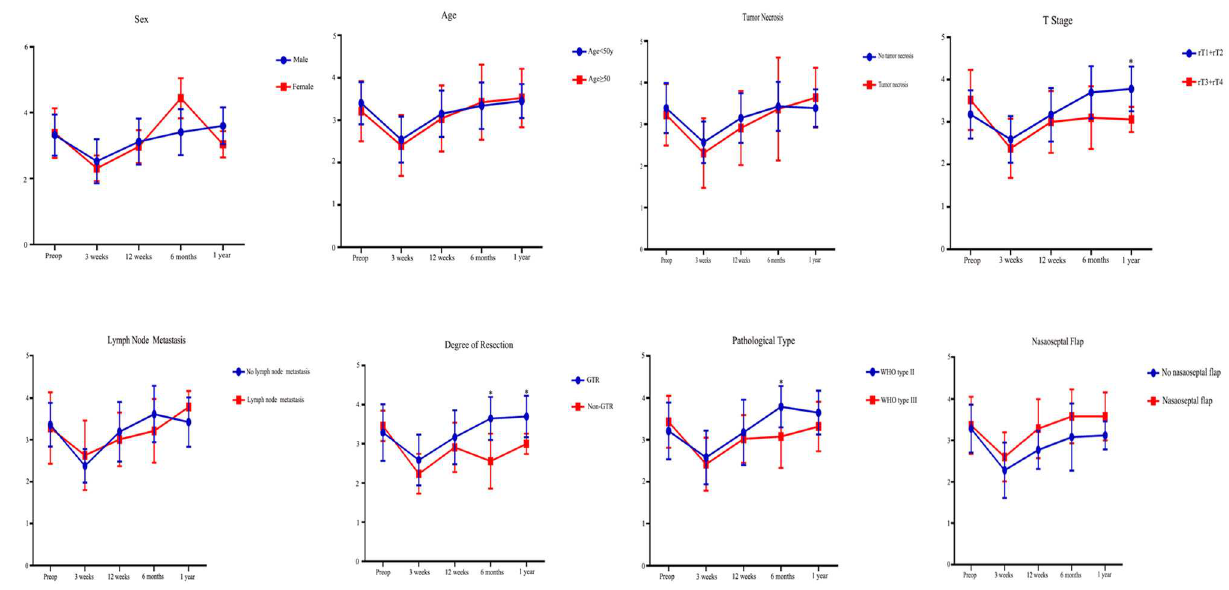
Frontiers in Oncology |